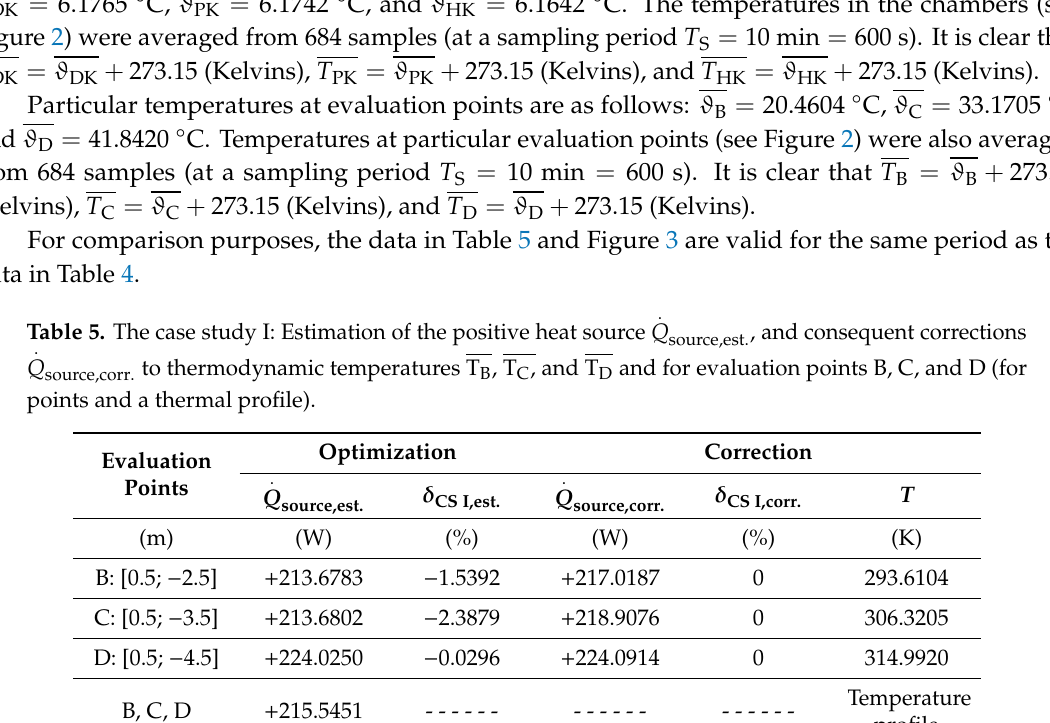
. Q source,est. for evaluation points B, C, and D.